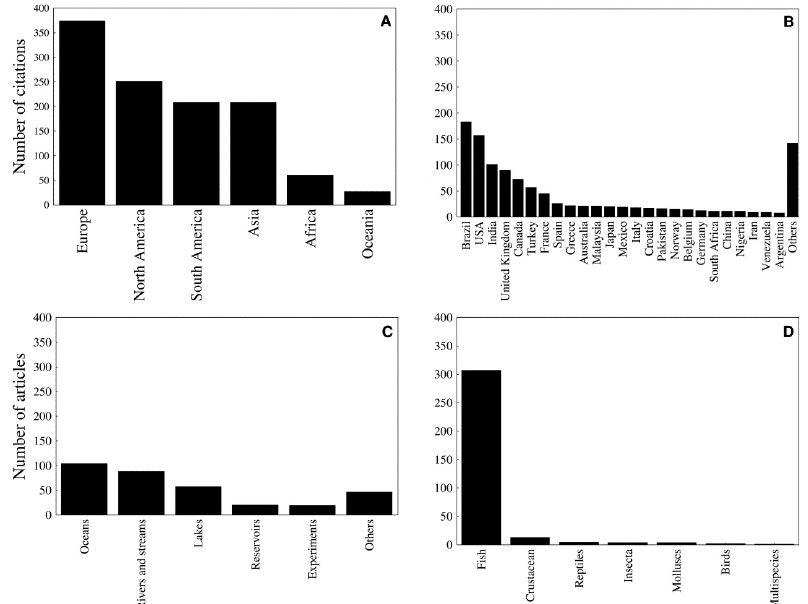
Figure 4. Number of citations of Le Cren’s (1951) paper (A) per continent and (B) per country of the first author and the number of articles that cited ‘Le Cren, 1951’ (C) per type of aquatic environment and (D) per organism based on a search from 1951 to December